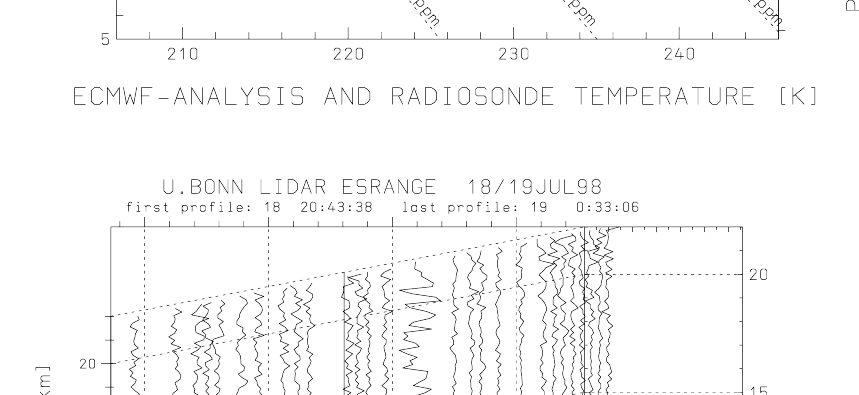
Fig. 1. The left points show the lidar backscatter ratio at wavelength 532 nm averaged in time from 2043 to 2247 UT on July 18, 1998. Temperature profiles ( right curves ) from ECMWF analyses and the midnight radiosondes launched at Bodø, 290 km west of Esrange, Sodankyla¨ , 245 km east, and Lulea˚ , 265 km south. Dashed oblique lines give water vapour saturation temperatures for hypothetical